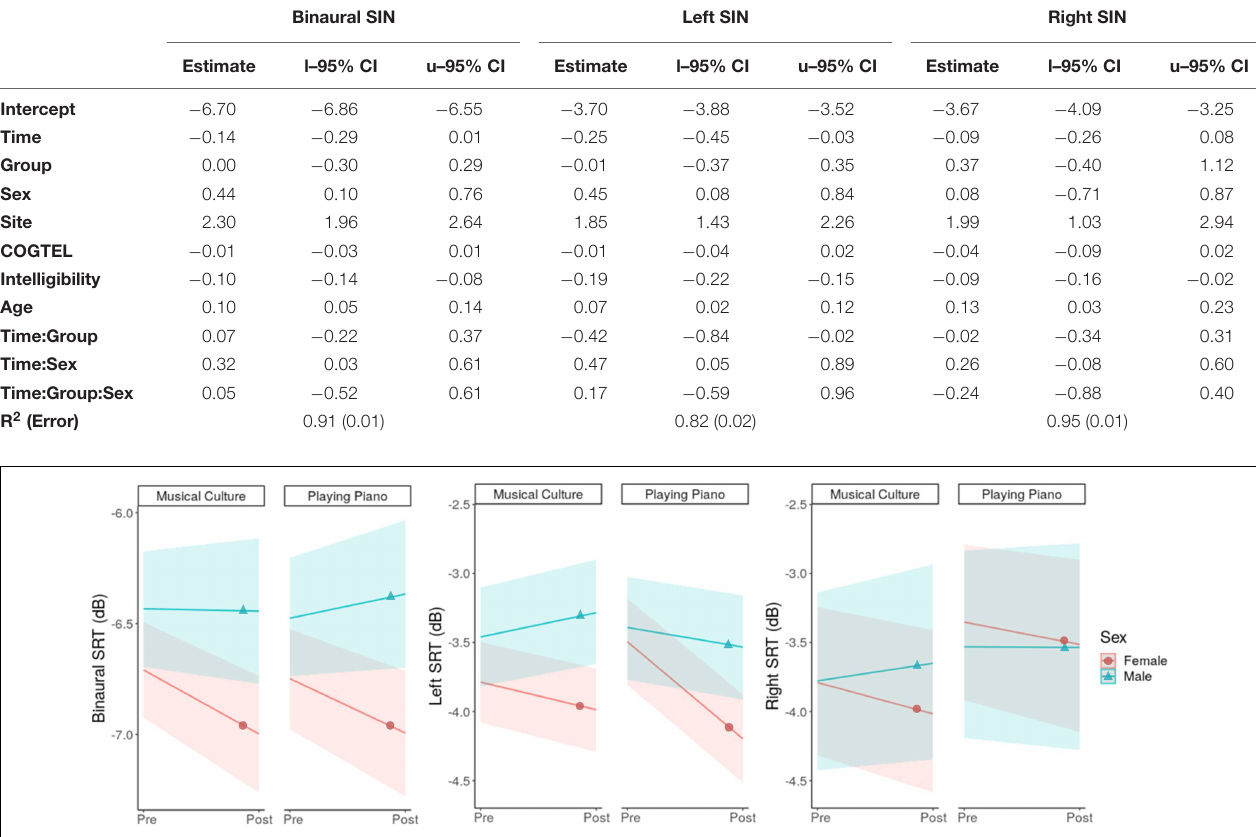
FIGURE 2 | Time-by-Group-by-Sex interaction plots for binaural, left and right SRT. The solid lines represent the estimated averages and the shaded areas their CIs.